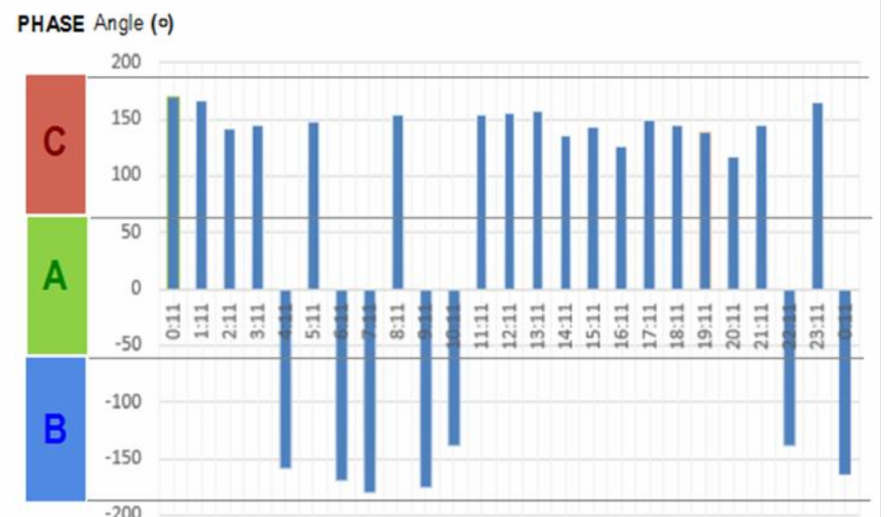
Figure 14. Representation of the transformer phases with most active powers on weekdays (the ends of the bars indicate the phase or phases that were the most